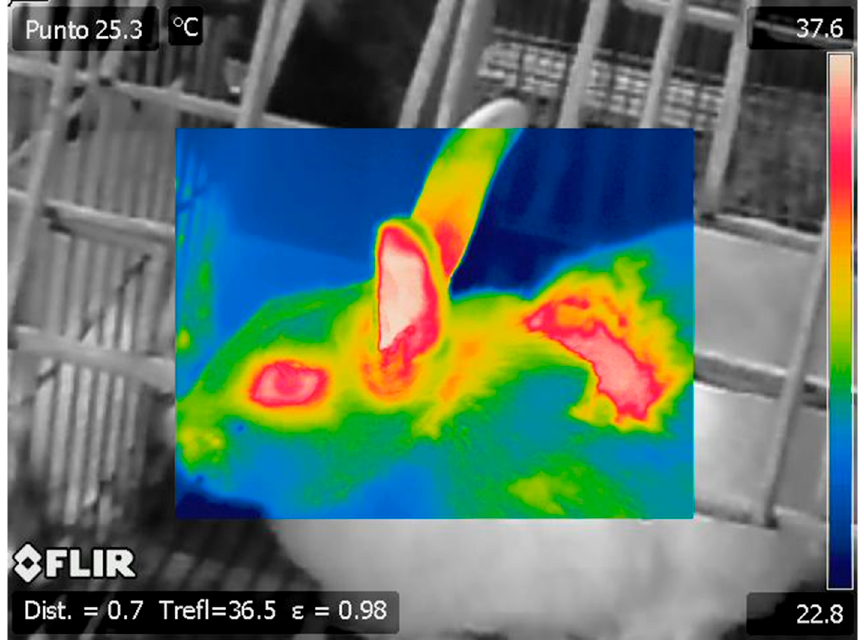
Figure 1. Thermographic image of a rabbit photographed with the ® FLIR SC660 thermal imaging